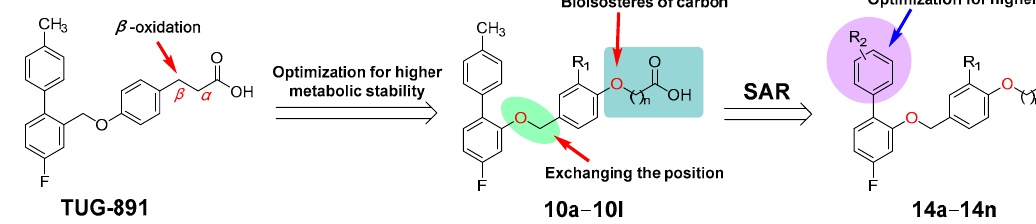
Figure 1. Representative GPR120 agonists.